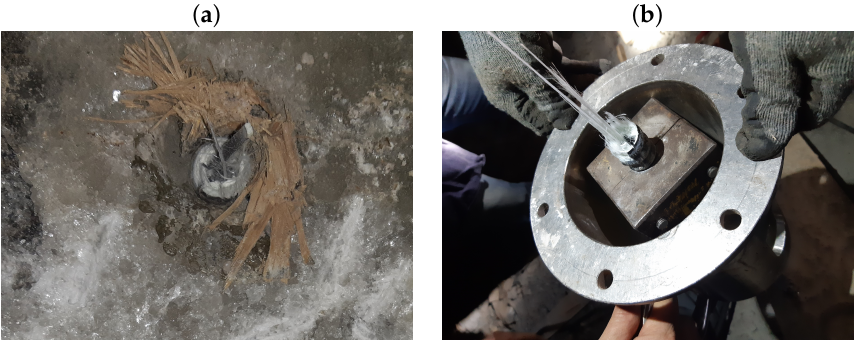
Figure 17. Anchor K3 (Vernier) after breaking using destructive test: ( a ) roof anchor; ( b ) broken